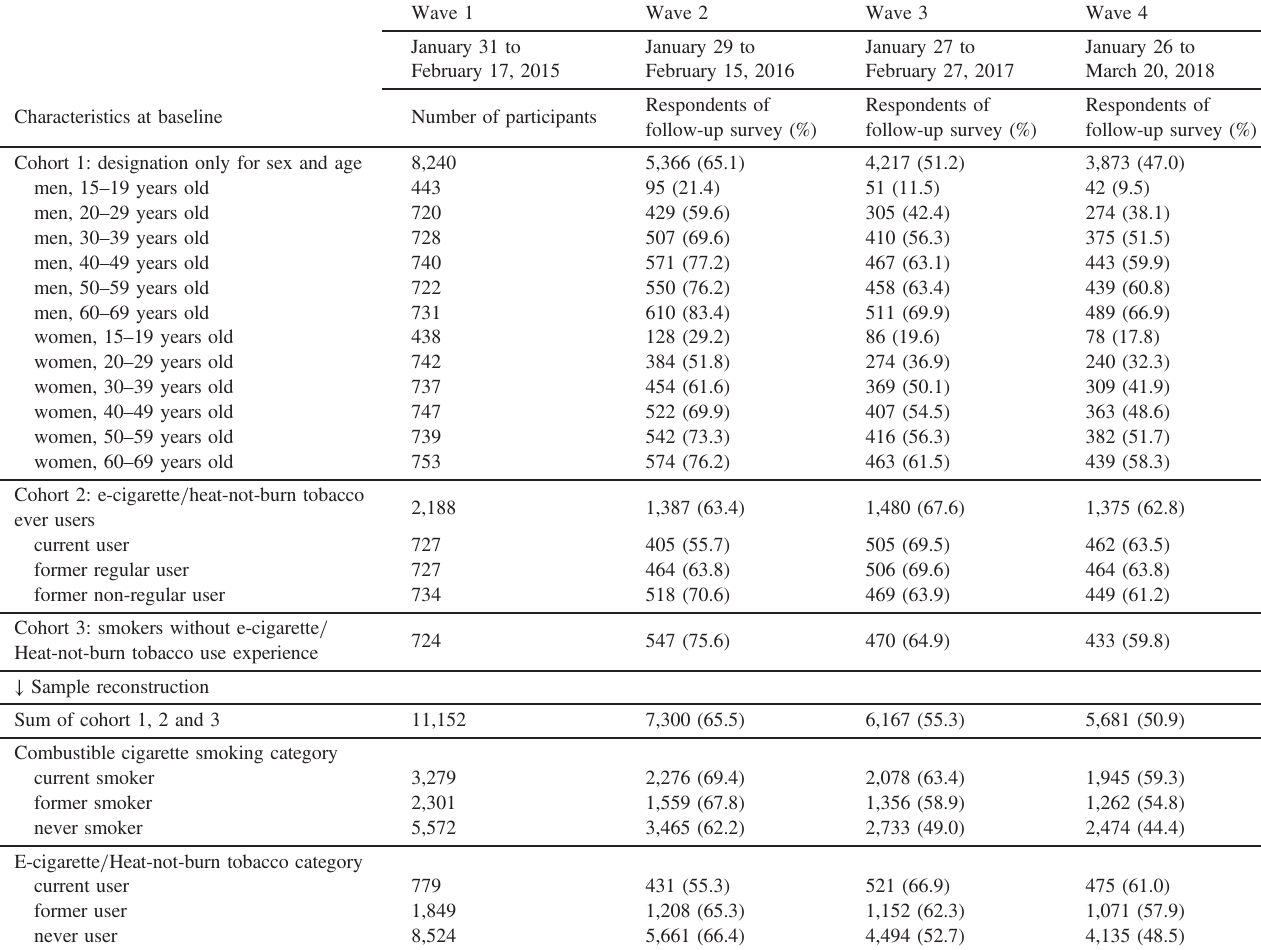
Table 2. Number of participants in the JASTIS study (Cohort 1, 2 and 3) Wave 1 Wave 2 Wave 3